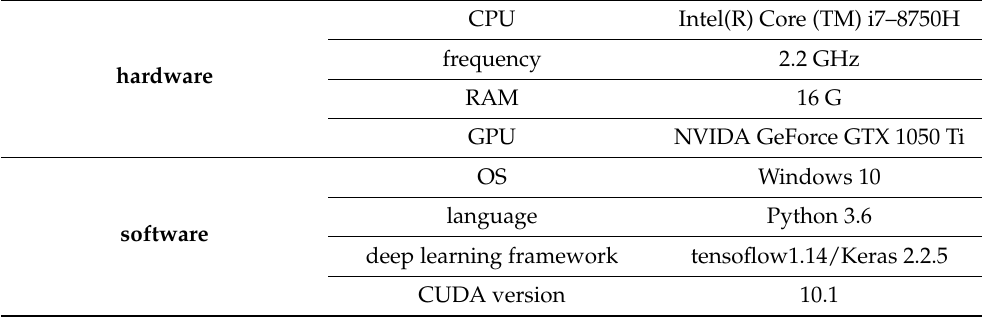
Table 1. Overview of platform setups.